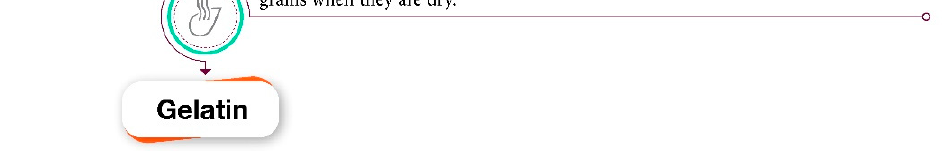
Figure 2. Steps of the gelatin manufacturing processes from animals.